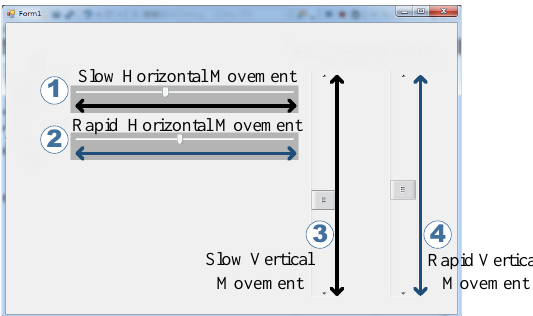
Figure 5. Experiment user interface: 1 is for slow horizontal movement, 2 is for rapid horizontal movement, 3 is for slow vertical movement, and 4 is for rapid vertical movement. The double arrow in the figure presents the direction of each relative movement. Adapted from [24].